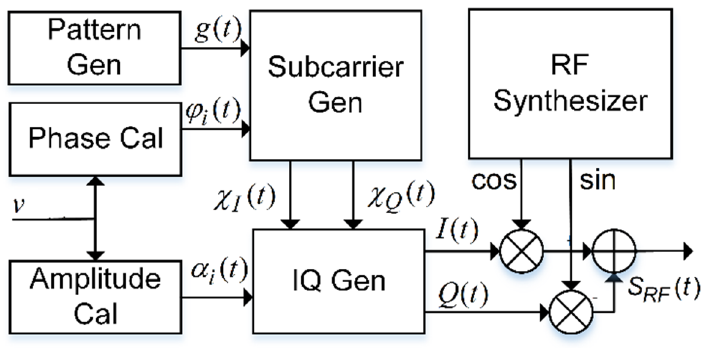
Figure 4. Direct generation with decomposed subcarriers. 4.2. Phase Rotation Generation The scheme of phase rotation generation is shown in Figure 5. According to the value of the signal components, frequency-hopping pattern, and time index,